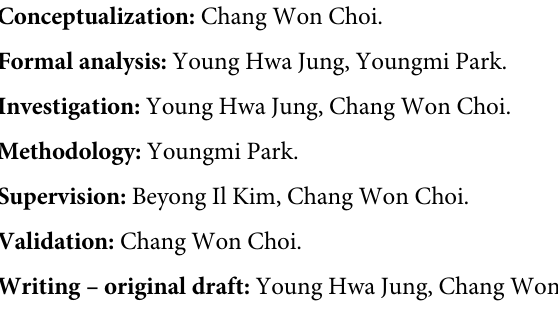
S1 Table. Maternal and neonatal characteristics between survival without BPD until 36 weeks of postmenstrual age group and BPD or death before 36 weeks of postmenstrual age